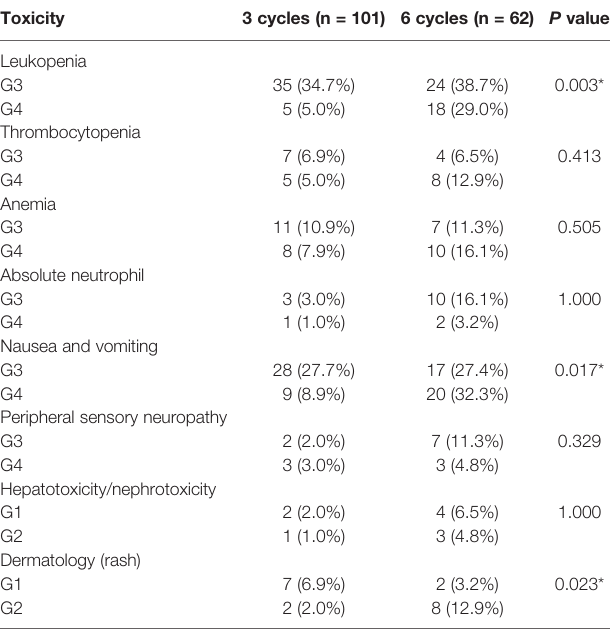
TABLE 4 | The associations of postoperative ACT with toxicity in optimal responders. Toxicity 3 cycles (n = 101) 6 cycles (n = 62) P